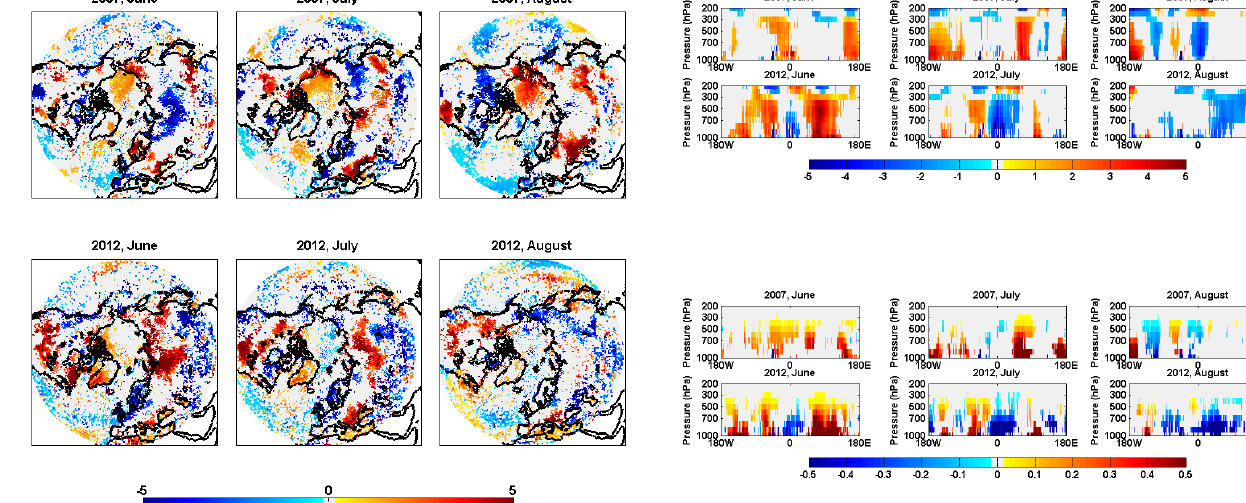
Fig. 10. Same as in Fig. 4, but for the summer months. Fig. 10: Same as in Fig. 4, but for the summer months.